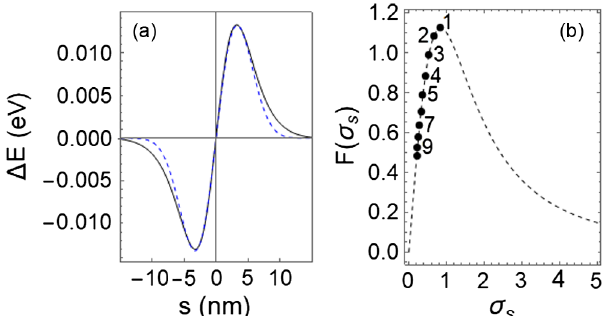
FIG. 4. (a) The energy change of the electrons calculated using (3) (black curve) and an approximating function (dashed blue curve). (b) The normalized cooling force. Only one half of the electrons with positive values is shown. The dots show optimal σ s 0 for the cascade with the number of cooling sections written next to the